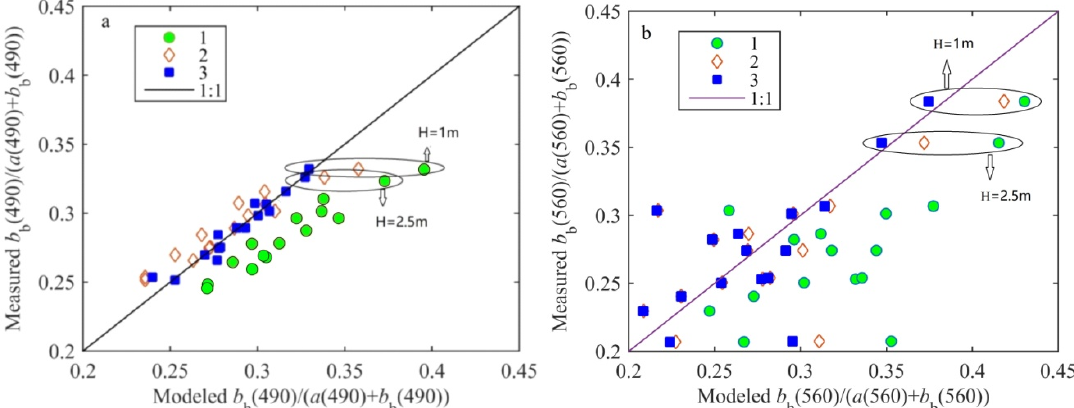
Figure 7. Comparison between u ( λ ) calculated by in situ data and those calculated by remote sensing reflectance data (1, calculated by R ap ; 2, calculated by R rs ; 3, calculated by r rs ) for ( a ) the waveband at 490 nm and ( b ) the waveband at 560 nm.